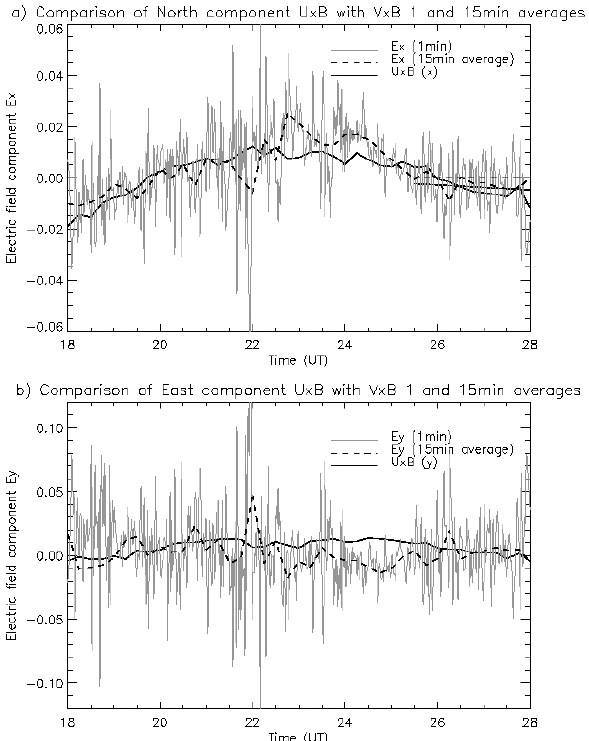
Fig. 6. Comparison of the north and east components of the mag- netospheric electric field ( V × B ) using 1-min and 15-min averages with the neutral wind dynamo ( U × B ) on the night of 27–28 Febru- ary